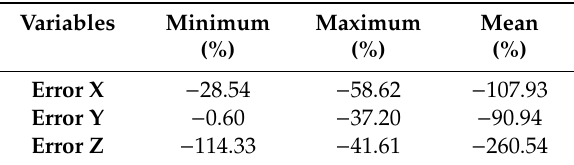
Table 7. Fifty GCP stage 1 vs. 50 GCP stage 2.